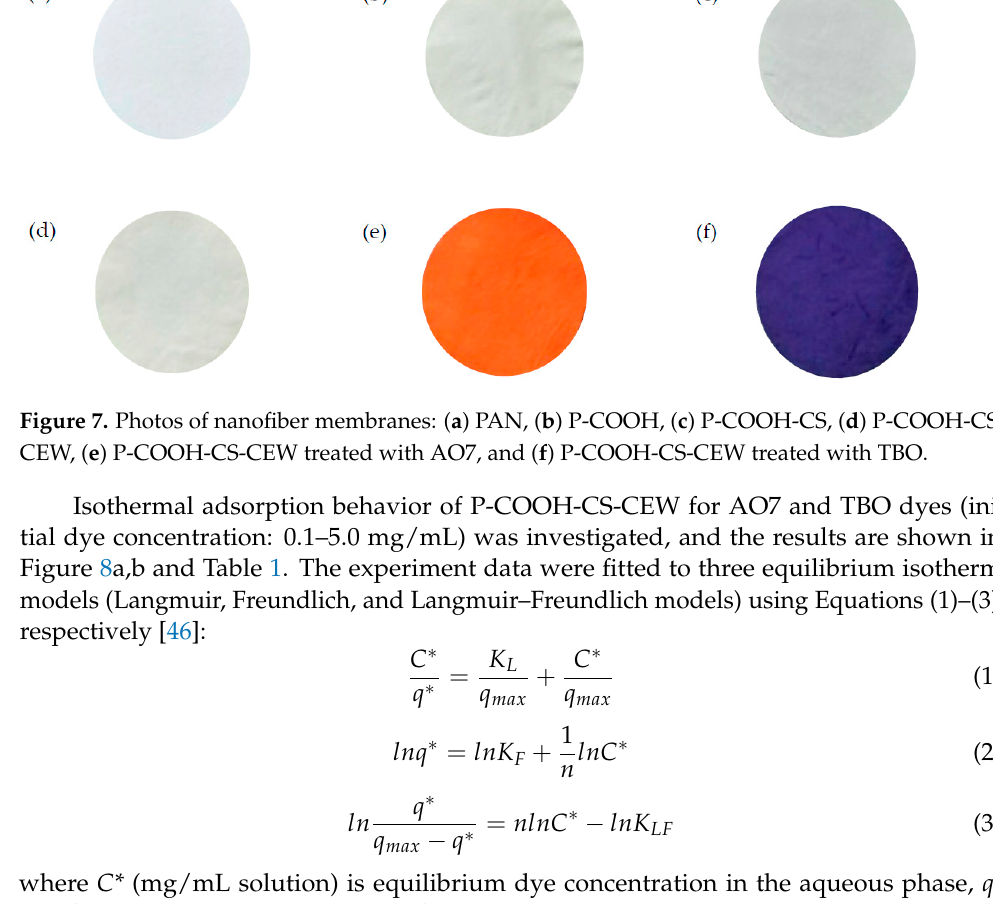
Figure 6. ( a ) Effect of buffer pH on the adsorption of AO7 and TBO on P-COOH-CS-CEW nanofiber membrane. ( b ) A comparison of binding capacity of different nanofiber membranes for AO7 and TBO dyes. Operating conditions: ~0.03 g of nanofiber membranes incubated in 5 mL of dye solution